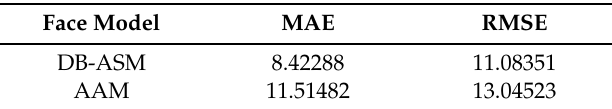
Table 2. Comparison of fitting performance between AAM (Active Appearance Model)and DB-ASM (Discriminative Bayesian-Active Shape Model).